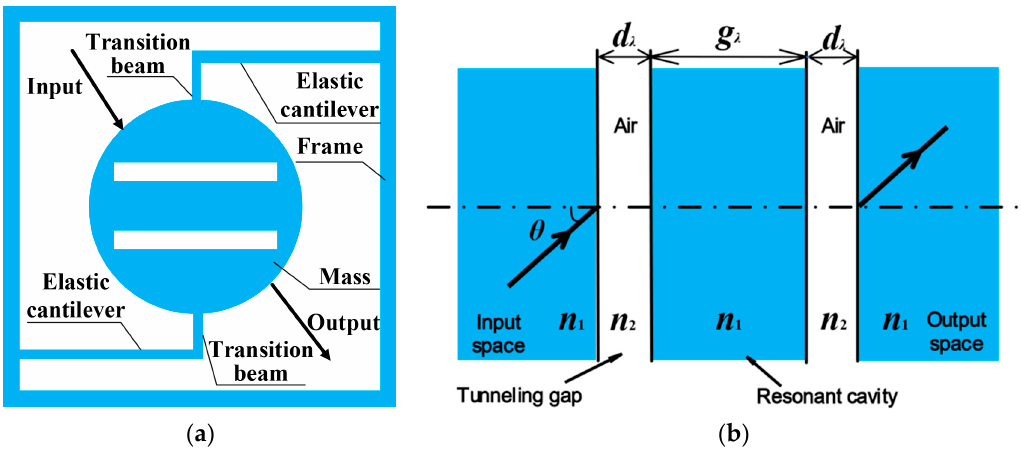
Figure 1. Device structure design and schematic diagram of the acceleration sensor. ( a ) Top diagram of the accelerometer structure; ( b ) Optical model of the ROTE structure. Table 1. Partial design parameters of the sensor structure ( μ m).